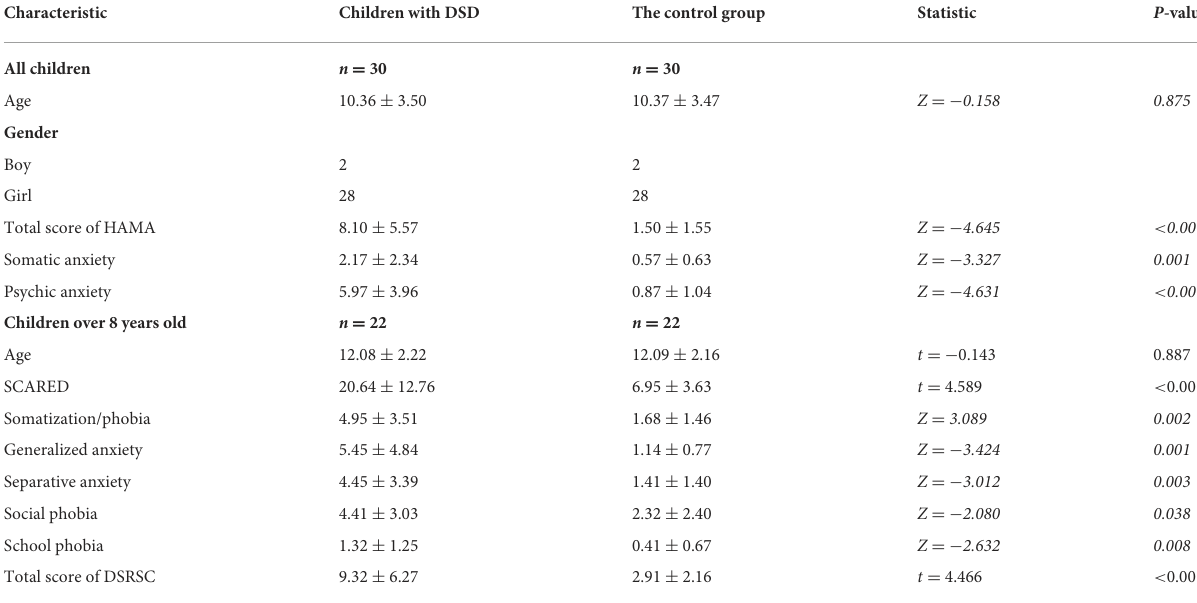
TABLE 1 Comparison of the he results of HAMA, SCARED, and DSRSC between DSDs children and controls. Characteristic Children with DSD The control group Statistic P -value